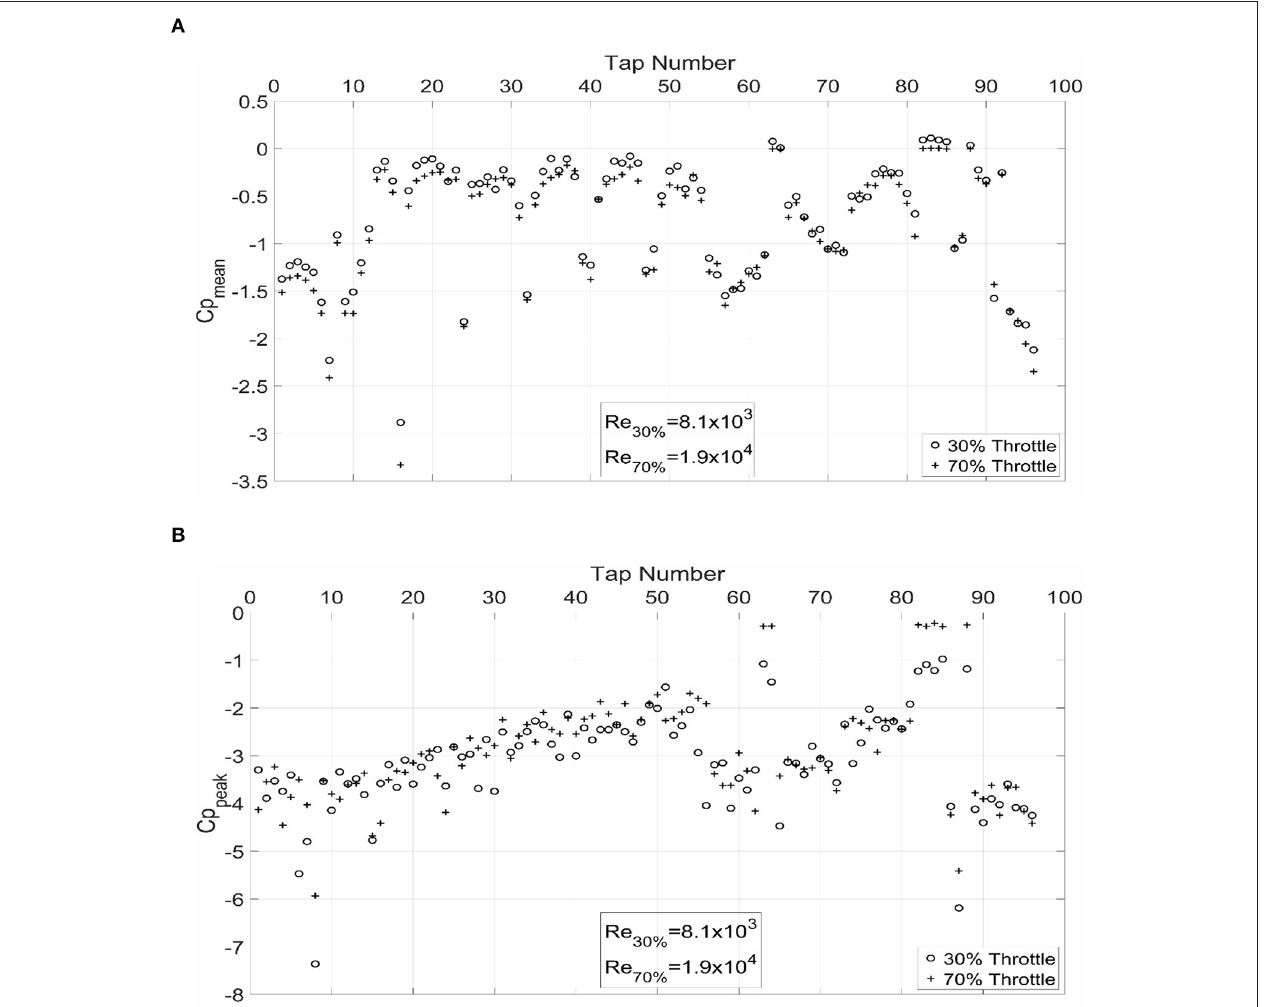
FIGURE 7 | Comparisons for 30 and 70% throttle speeds: (A) Cp mean , and (B) Cp peak